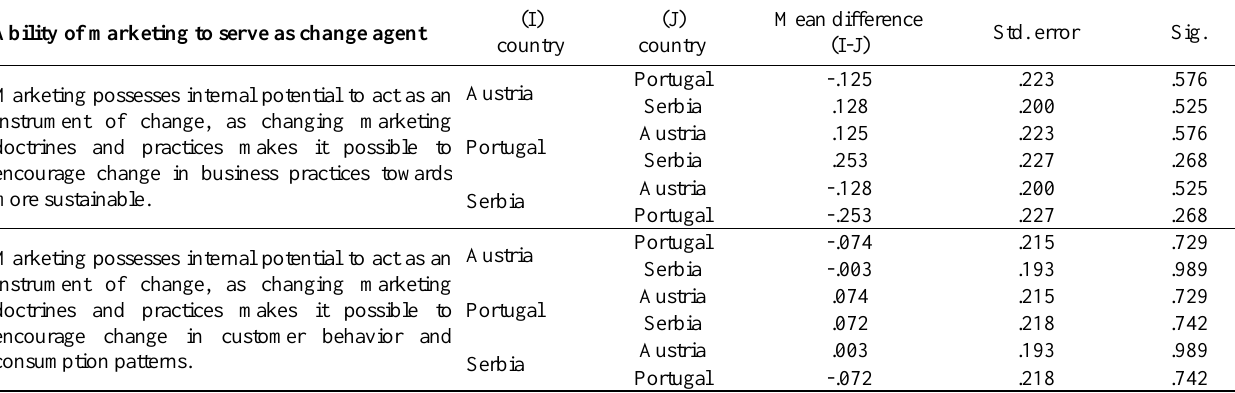
Table 8: Post-hoc test: LSD multiple comparisons Ability of marketing to serve as change agent